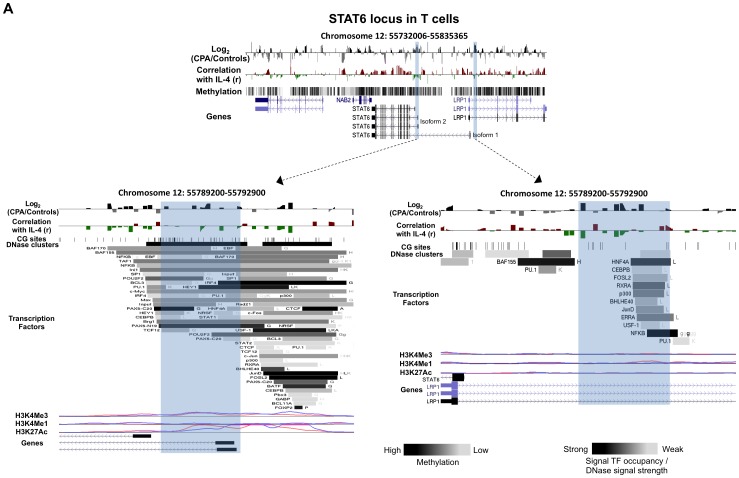
DNA methylation differences between CPA (n = 8) and control (n = 12) groups in cytokine’s transcription factor STAT6 in T cells.Expanded views from the UCSC genome browser of STAT6 (A) locus located on chromosomes 12 is depicted (top panel). In both panels, the first track shows the average MeDIP probe log2-fold differences (scale top panel: −0.4 to 0.4, botom panel: −1.0 to 1.0) between chronic physical aggressive (CPA) and control groups for T cells. In black are probes that are more methylated and in gray are those that are less methylated in the CPA group. Highlighted in blue are regions significantly differentially methylated between the groups. The second track shows Pearson’s correlation coefficient (scale top panel: −0.4 to 0.4, botom panel: −0.6 to 0.6) calculated between MeDIP microarray probe intensities and the plasma IL-4 (first) and IL-10 (second) levels obtained from the same subject. These correlations did not reach significance after correcting for multiple testing in T cells. In red are probes whose methylation levels correlate positively with the cytokine level in plasma and in green are those that correlated negatively. In the top panel, the last track shows the average methylation level for all the subjects in T cells estimated from the microarray data (n = 20). The bottom panel shows the two regions close to the TSS of each STAT6 isoform where the CPA group is found significantly more methylated than the control group. The regulatory elements from ENCODE identified in these regions (see methods) are shown in the additional tracks. First, shown with black lines, is the location of individual CpG sites. Second, is the location of DNase hypersensitive clusters where black indicate strong signal and grey a weaker signal from ChIP-seq data in 24 cell lines. Third is the location of transcription factors (TF) identified from ChIP-seq data in 24 cell lines where black indicate a strong presence and grey weaker signal occupancy. The letter next to the TF boxes identified the cell line where it was found enriched (see Table S1 for the full legend). The last tracks, identified the level of enrichment of three histone marks determined from ChIP-seq assay, histone 3 lysine 4 tri- and mono-methylation as well as histone 3 lysine 27 acetylation in two cell lines, GM12878 (pink) and K562 [106].